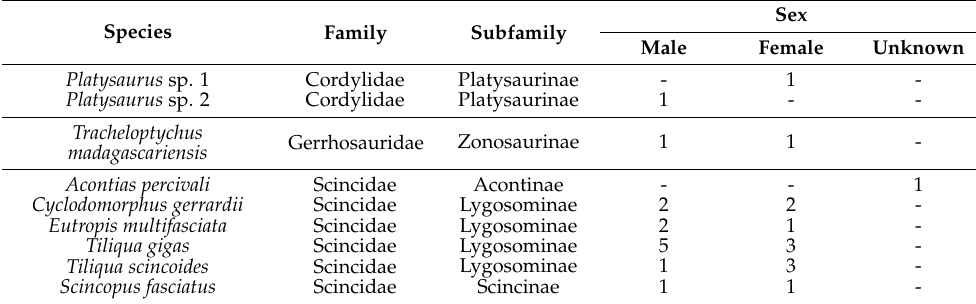
Table 1. Species analyzed in the present